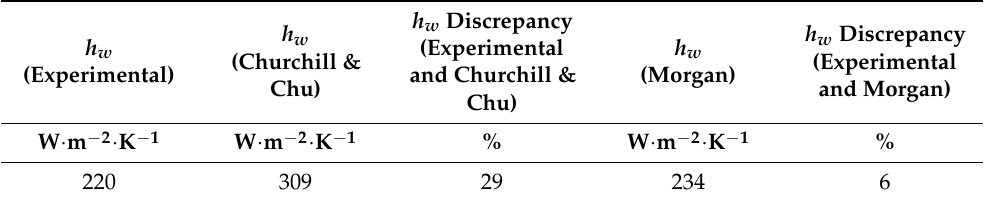
Table 4. Experimental and theoretical values of the heat transfer coefficient of the water around the experimental tube without